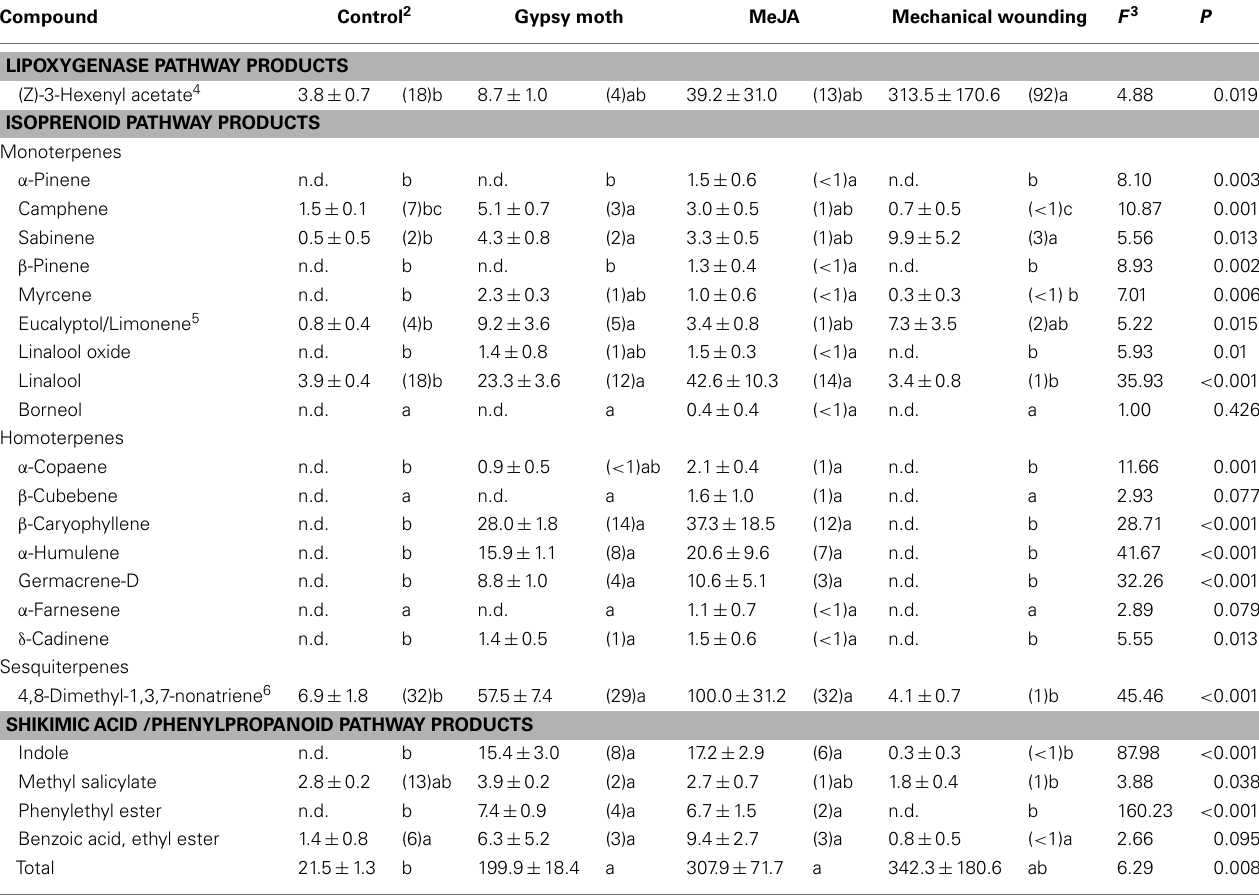
Table 2 |Volatiles identified in the headspace of cranberry, Vaccinium macrocarpon , plants damaged by eight gypsy moth larvae, sprayed